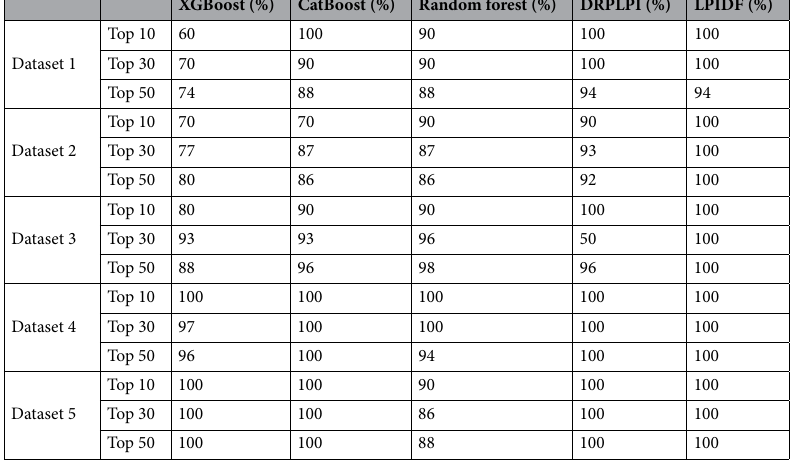
XGBoost CatBoost Random forest DRPLPI